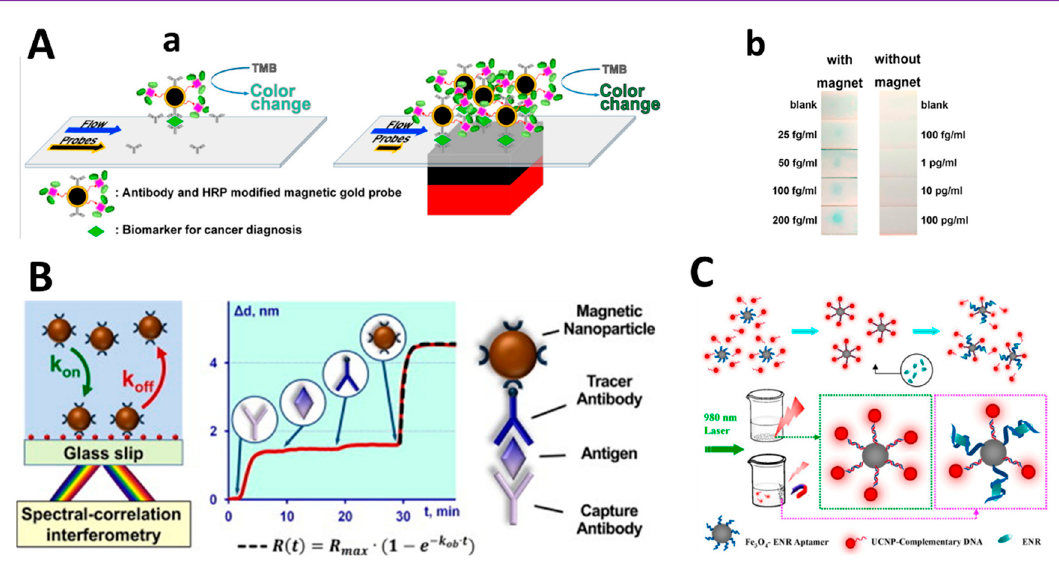
Figure 4. ( A ) ( a ) Schematic depicting the e ff ect of magnetic focus lateral flow biosensor. Without the magnet, the magnetic probe-labeled targets move along with the sample flow on the lateral flow strip, resulting in a low capture e ffi ciency (left). With magnet, the probe-labeled targets are focused at the signal generation zone due to the magnetic focus thus increasing the capture e ffi ciency of labeled targets (right). ( b ) Comparison of the detection results with and without magnet. Reproduced with permission from Reference [53]. Copyright 2019 American Chemical Society. ( B ) Sandwich immunoassay